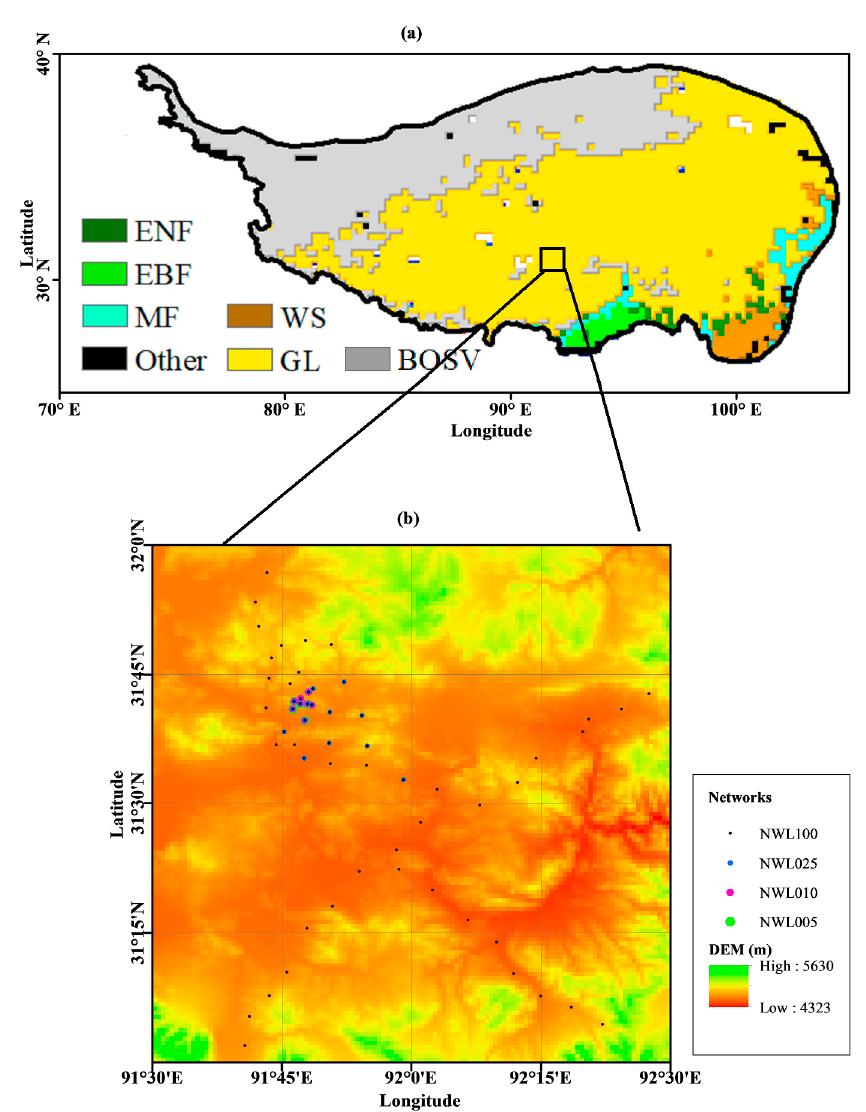
Figure 1. Study area: ( a ) MODIS land cover types aggregated to 0.25° over the Tibetan Plateau, where EF: Evergreen Needleleaf Forest; EBF: Evergreen Broadleaf Forest; MF: Mixed Forest; WS: Woody Savannas; GL: Grasslands; BOSV: Barren or Sparsely Vegetated. and ( b ) Naqu soil moisture monitoring network and the distribution of measuring stations based on the Digital Elevation Model map, where NWL100, NWL025, NWL010 and NWL005 are four filed networks with size of 1° × 1°, 0.25° × 0.25°, 0.10° × 0.01°, 0.05° × 0.05°.